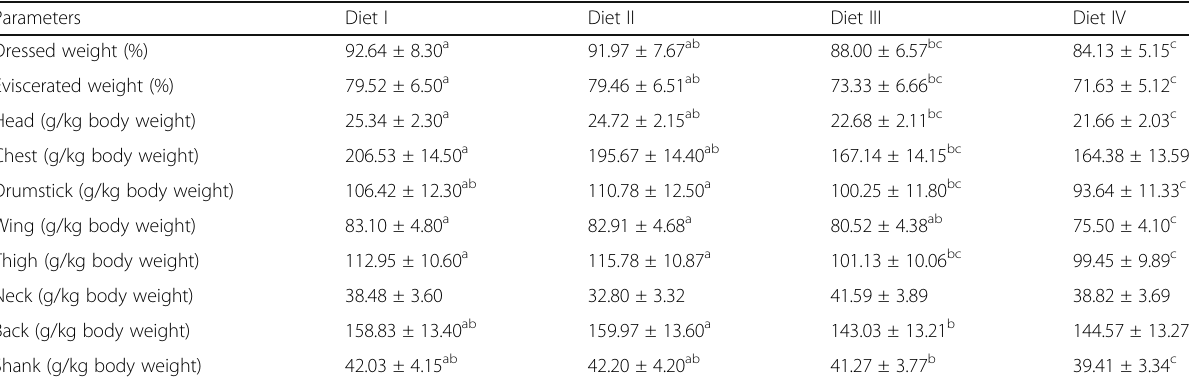
Table 5 Carcass traits (g) of broiler chickens fed with diets containing fortified bread waste meals